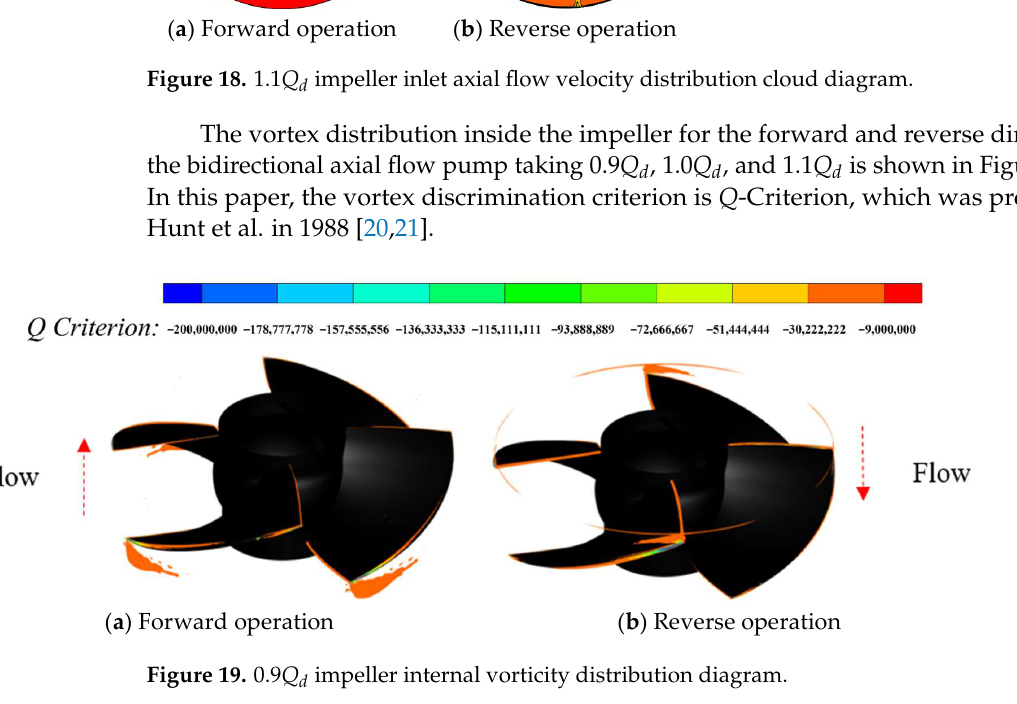
Figure 18. 1.1 Q d impeller inlet axial flow velocity distribution cloud diagram.